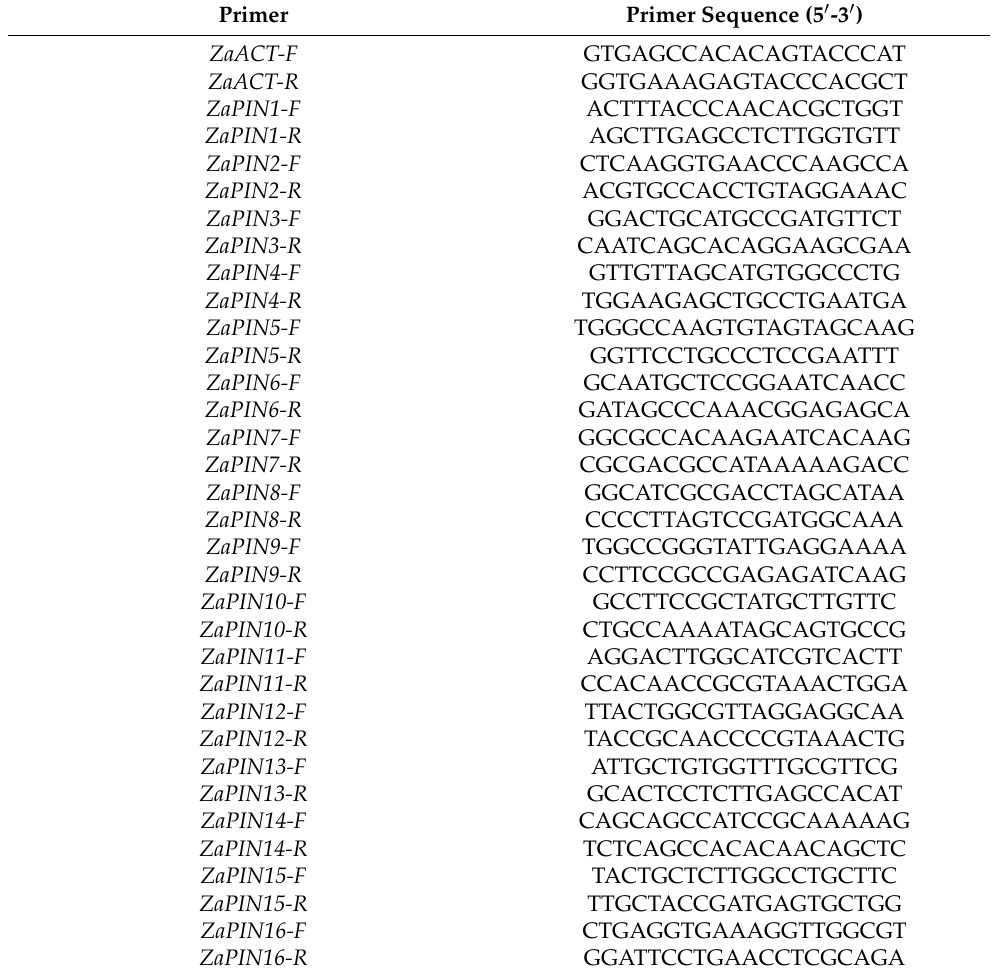
Table 1. Primers used for qRT-PCR